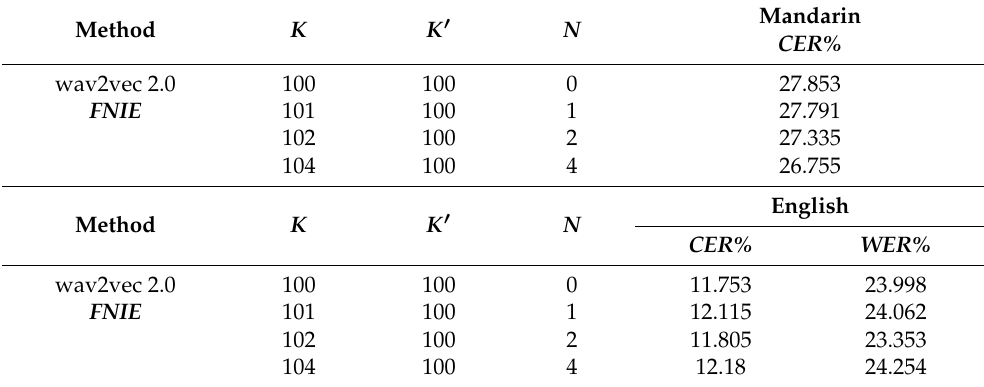
Table 2. Comparison of deleting different numbers of false negative